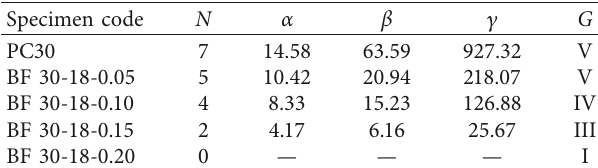
Figure 12: Ratio of crack resistance index for BFRC specimens with different fiber lengths as compared to plain concrete (PC) specimen. Table 7: Crack length of test specimens with different fiber volume fractions.